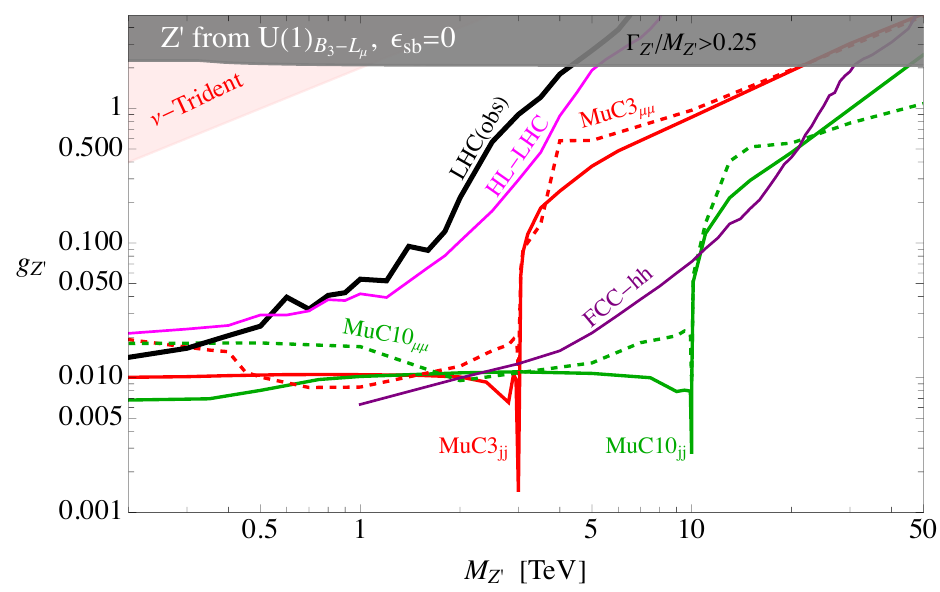
Figure 9 . Discovery reach at 5 σ for the B 3 − L µ model with (cid:15) sb = 0 , for different final states at each collider (as indicated by the labels). The region excluded at 95% CL by LHC [88] is above the black line while in the dark gray region the Z 0 has a large width, signaling a loss of perturbativity. where the top mass is neglected (in the numerical study we keep finite m